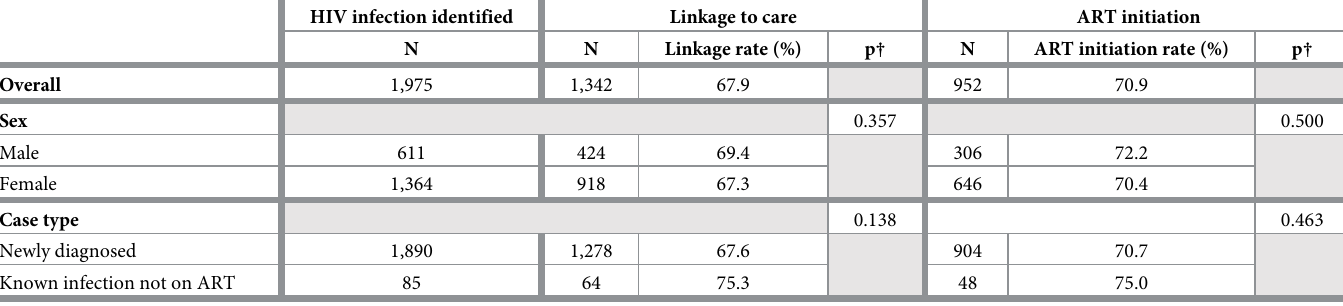
Table 1. People living with HIV (PLHIV) age � 15 years linkage to care (LTC) and antiretroviral therapy (ART) initiation by category of self-report HIV status and sex, NAIIS 2018. HIV infection identified